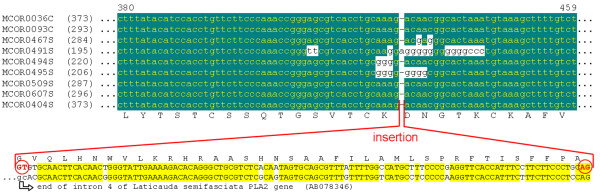
Segment of PLA2 clusters, showing the presence of a 114 bp insertion in MCOR0404S. This inserted sequence is very similar to the last 114 bp of the fourth intron of PLA2 gene from several snakes, including L. semifasciata (aligned above the insertion), and is delimited by the canonic GT and AG in intron/exon junctions.